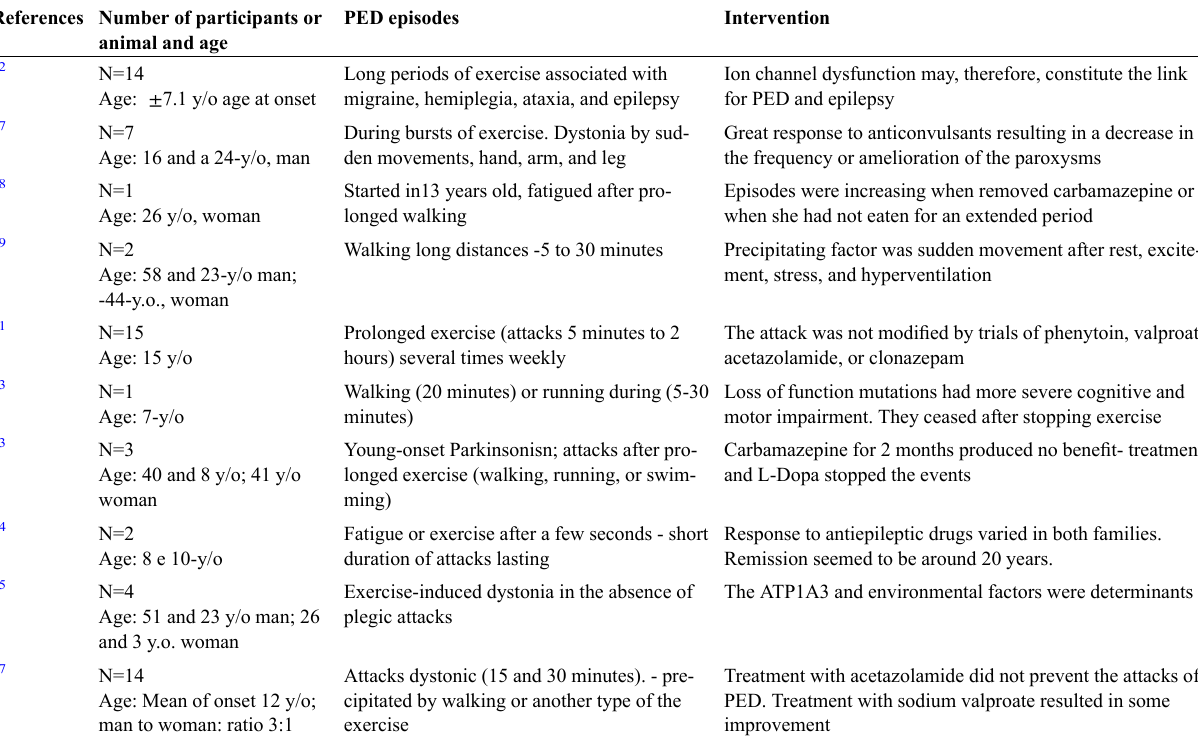
Table 3 - Characteristics of the original articles, selected in the bibliographic search, are PED and physical activity or exercise, from 1978 to 2012. References Number of participants or animal and